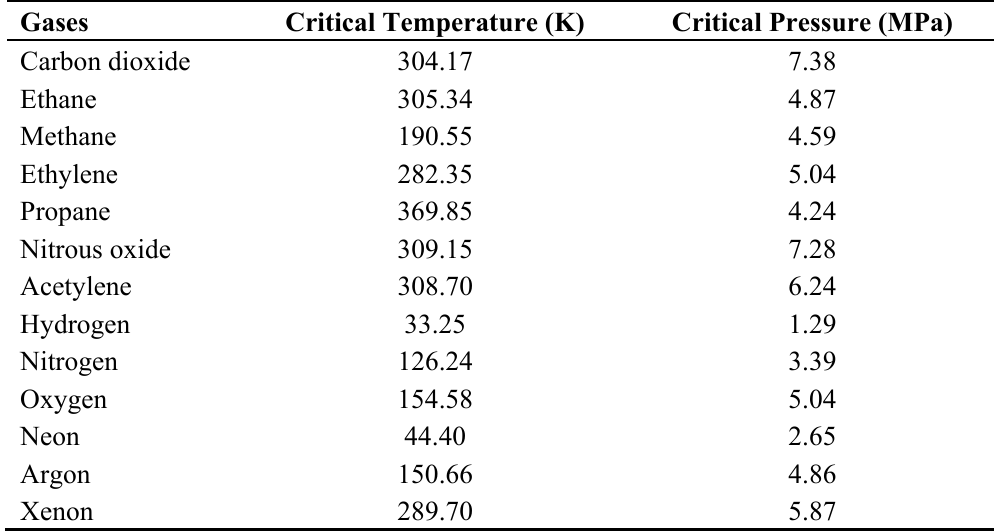
Table 1. Examples of substances used as supercritical solvents and its corresponding critical temperature and pressure. Reproduced with substantial modification from